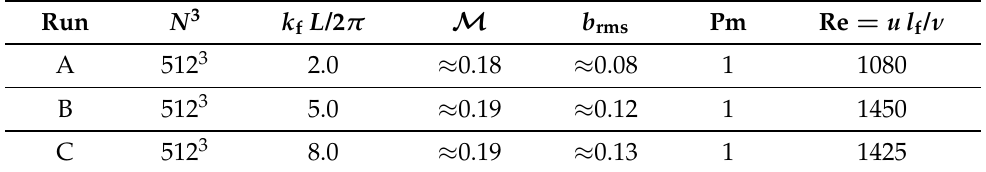
Table 1. Key parameters of the subsonic simulations used in this study. N is the number of grid points in each dimension, k f is the forcing wave number and L is the size of the simulation domain. and b rms are the average values of the rms Mach number and the magnetic field obtained in the M steady state. Pm and Re are the magnetic Prandtl and fluid Reynolds numbers,